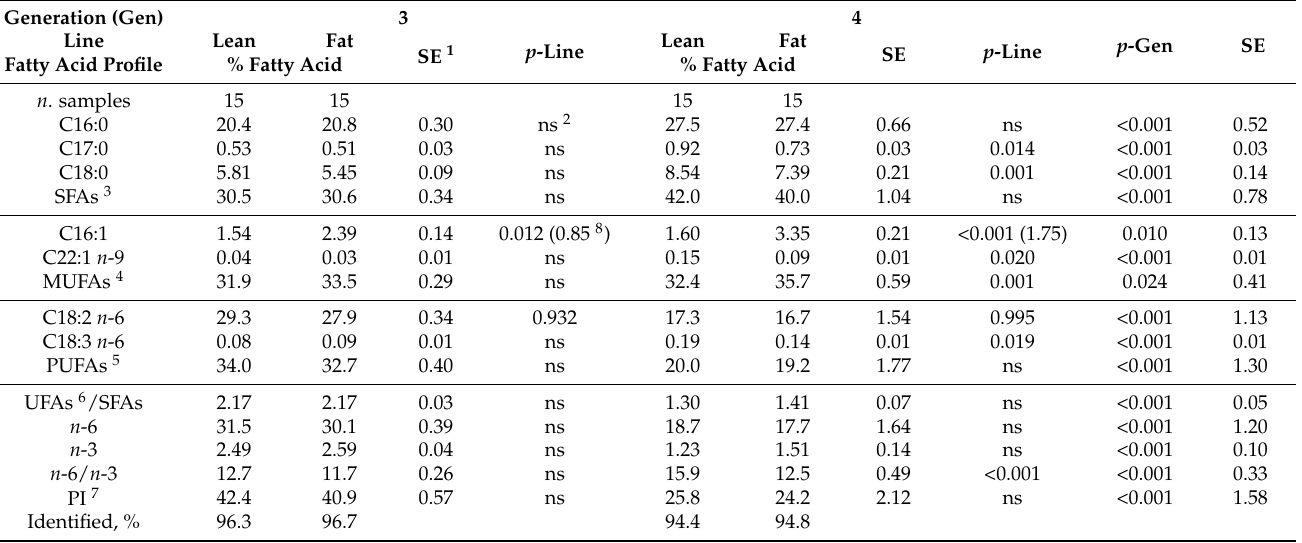
Table 5. Fatty acid profile (% of total FAMEs) of the abdominal wall of Lean and Fat rabbits in third and fourth generations of divergent selection for total body fat